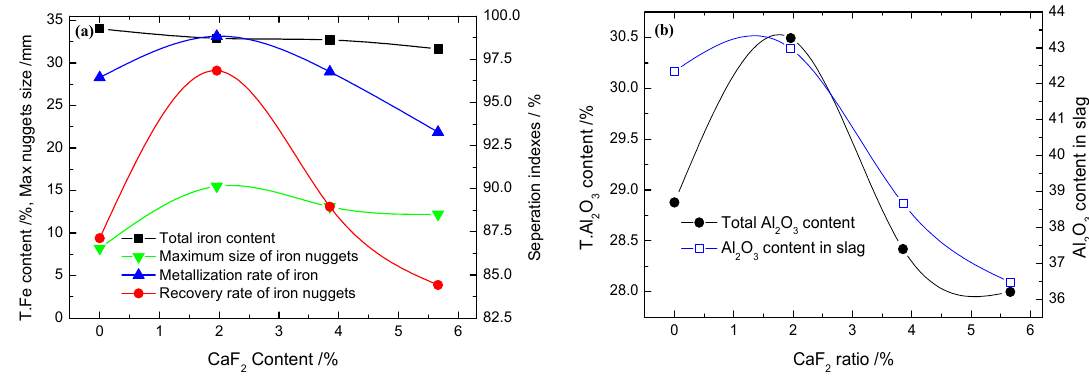
Figure 12. Effect of the CaF 2 ratio on the reduction indexes ( a ) and Al 2 O 3 ( b ).